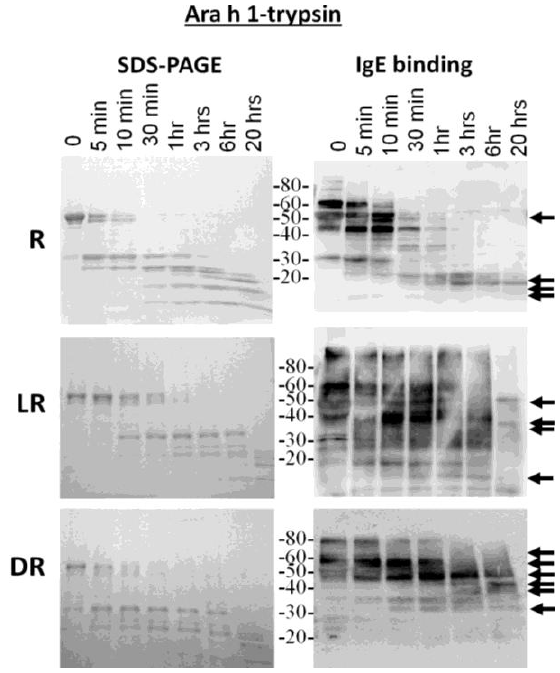
Figure 3. SDS-PAGE and IgE western analysis of the digestion of raw (R), light roast (LR) and dark roast (DR) Ara h 1 with trypsin. Raw Ara h 1 ( top ), light roast Ara h 1 ( middle) and dark roast Ara h 1 ( bottom ) were digested with trypsin for the designated amounts of time. Sample taken prior to addition of trypsin is Time 0. The molecular weights of the marker proteins are indicated on the